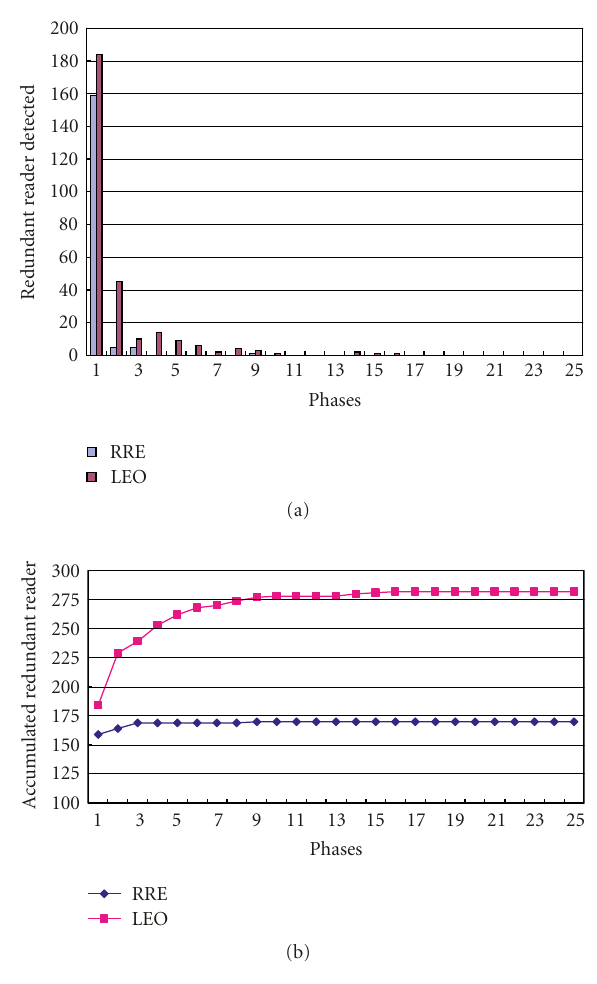
Figure 12: Comparison of number of redundant readers detected (a) and accumulated (b) with network area 10000 × 10000, reader radius = 500, number of tags = 4000, reader =